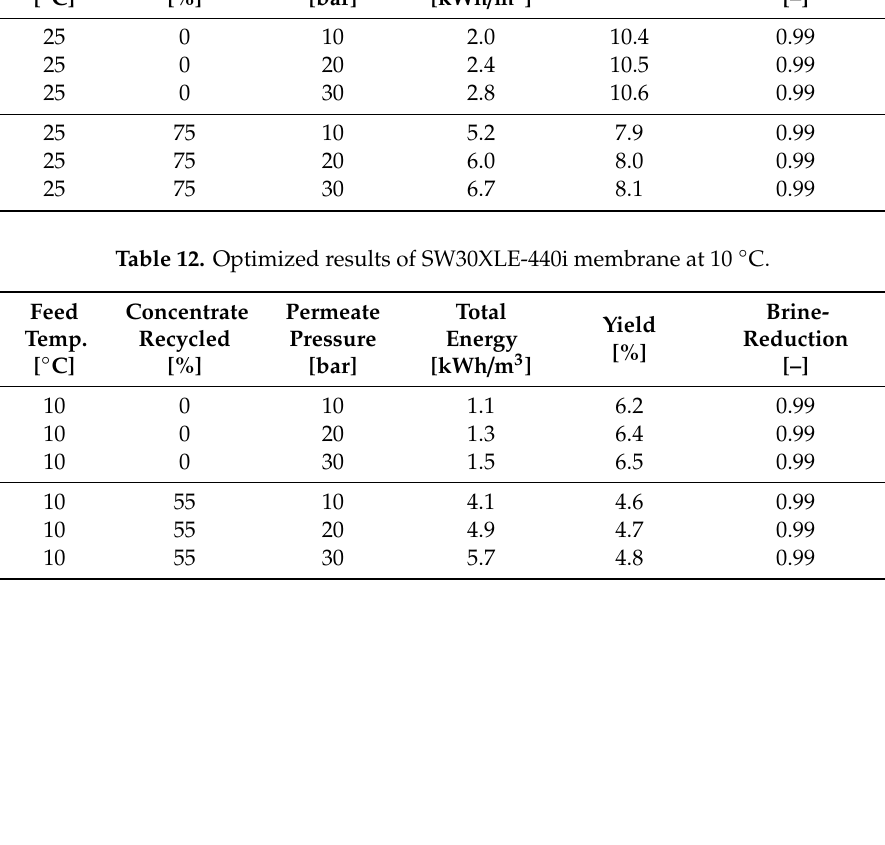
Table 11. Optimized results of SW30HRLE-440i membrane at 25 ◦ C. Feed temp.